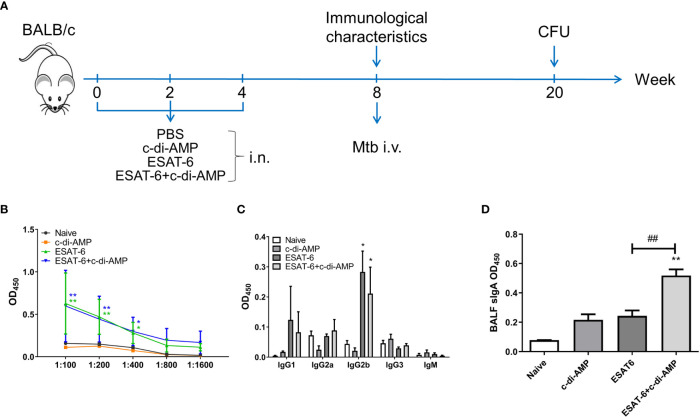
The subunit vaccine ESAT-6:c-di-AMP induced systemic IgG and enhanced mucosal sIgA. (A) The immunization and Mtb infection strategy scheme. Female BALB/c mice were immunized intranasally (i.n.) with PBS (Naïve group), c-di-AMP, ESAT-6, or ESAT-6 co-administrated with c-di-AMP, respectively. Mice were boosted twice at 2-week internals. Four weeks after the last immunization, mice were challenged intravenously (i.v.) with Mtb H37Ra at 5 × 104 CFU. (B) ESAT-6-specific total IgG in sera at a series of dilutions from 1:100 to 1:1 600. (C) ESAT-6-specific subclasses of antibody in sera (1:200) of immunized mice. (D) ESAT-6-specific sIgA in BALF of immunized mice were determined using ELISA. “*,” compared with the control group (Naïve). *P<0.05, **/##P<0.01, ***P<0.001.